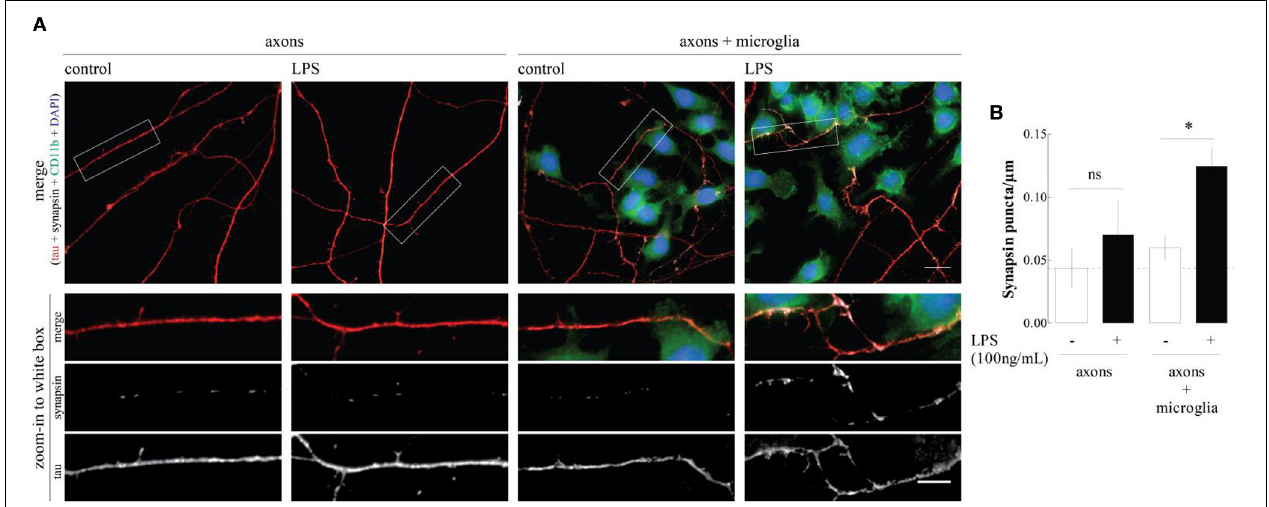
FIGURE 1 | LPS- primed microgial cells increase synapsin puncta along axons. (A) Representative images of the axonal/microglia compartment of microfluidic chambers in which rat embryo hippocampal neurons were allowed to grow for 7 days. When indicated, before axons arrival to the axonal compartment a microglia cell line was cultured (DIV3) and activated with LPS for 6h (DIV4). Cultures were stained for CD11b (microglia marker, green),